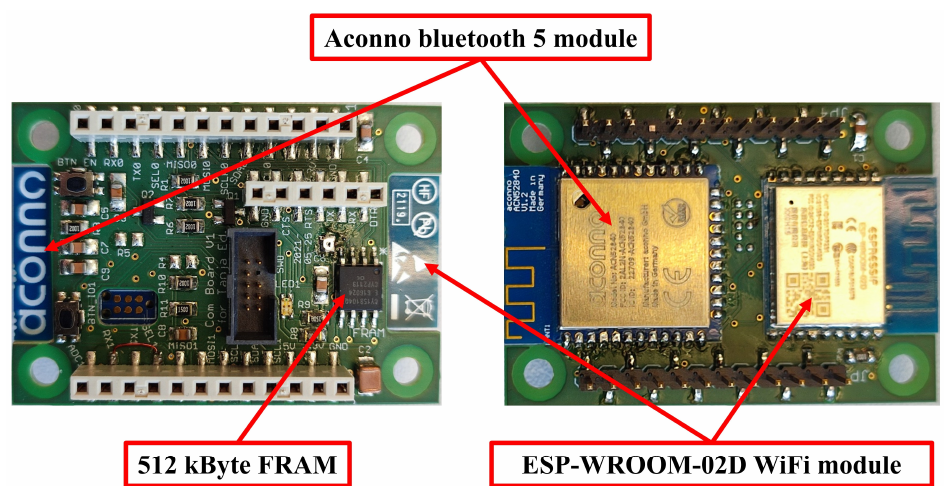
Figure 1. Communication layer (front and back views).